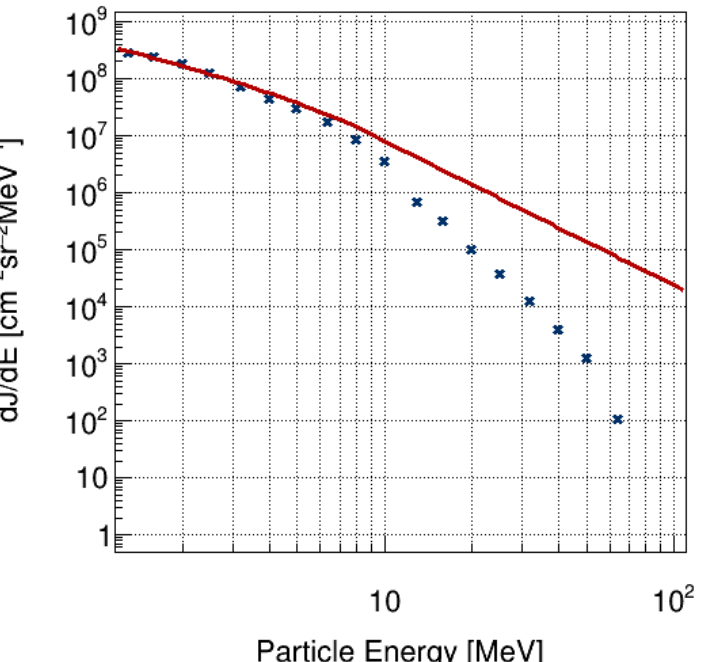
Figure 2. Fluence spectrum for energetic protons measured by SOHO/ERNE at L1 during FD in September 2017. Data points represent fluence integrated in different energy channels over time of duration of the event, while red line represents the fitted double power law.